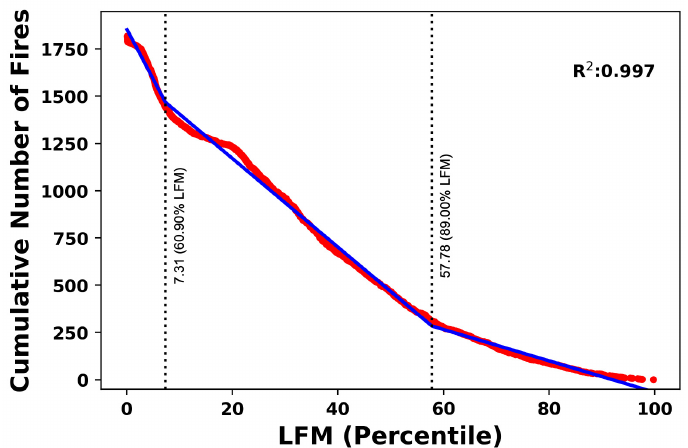
Figure 6. LFM of observed predicted LFM percentiles vs. cumulative number of fires. Dashed lines indicate calculated breakpoints between LFM domains (measured both as LFM percentile rank and actual LFM).